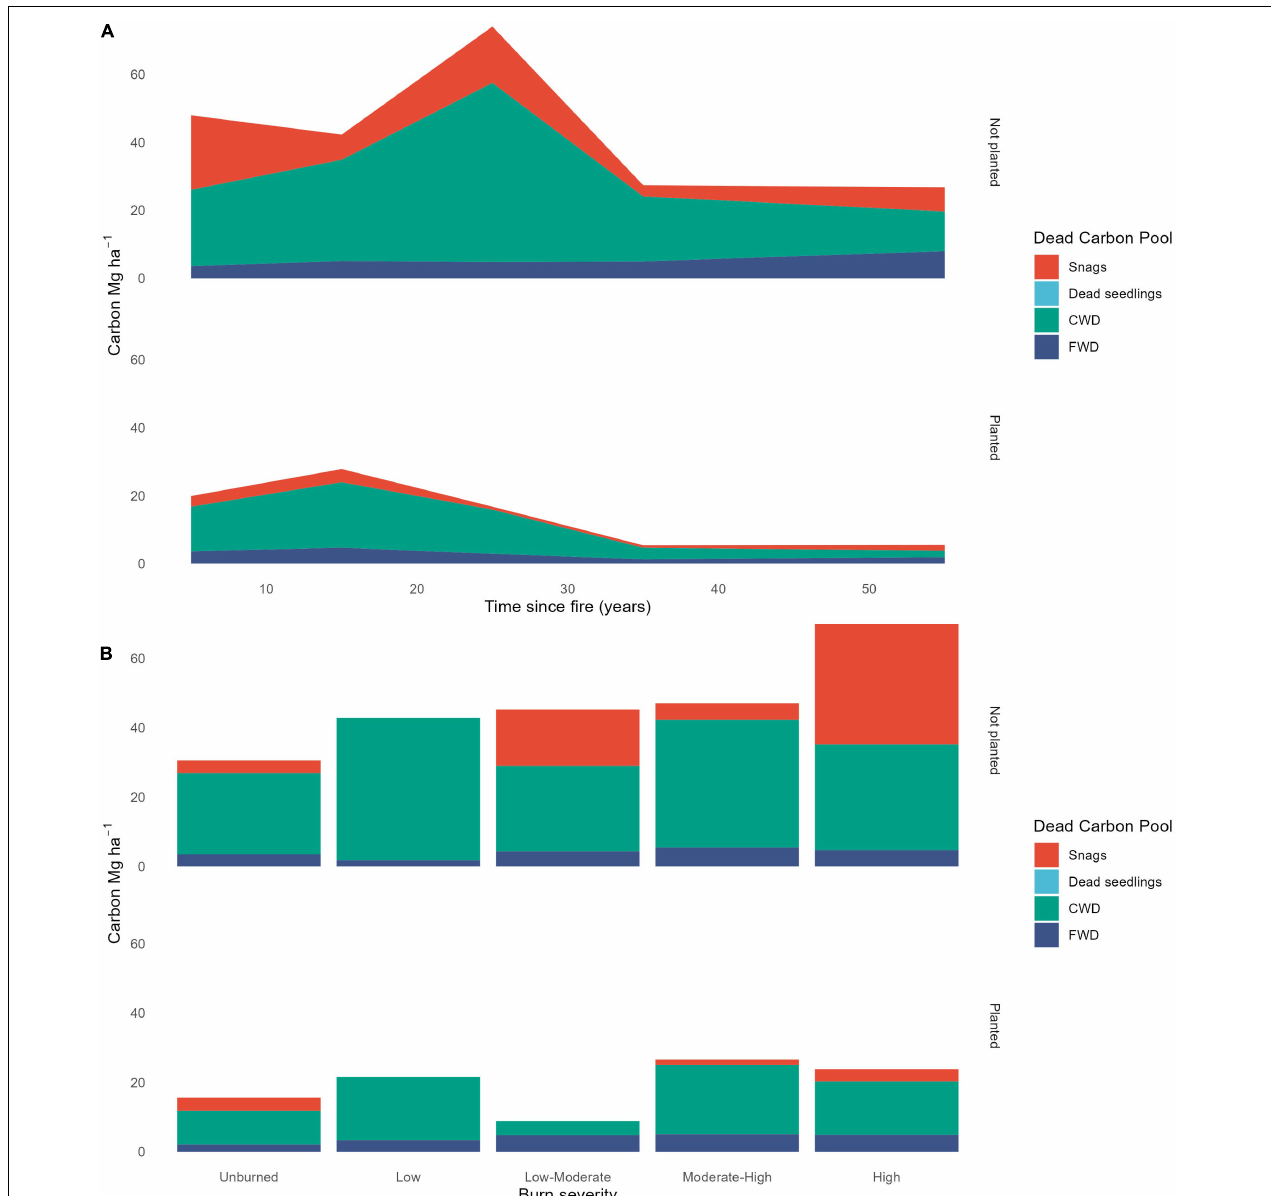
FIGURE 4 | The contribution of standing snags, dead seedlings, coarse (CWD) and fine (FWD) woody debris to the dead carbon pool (A) over time since fire ( N = 75) and (B) by burn severity class ( N = 53 plots post